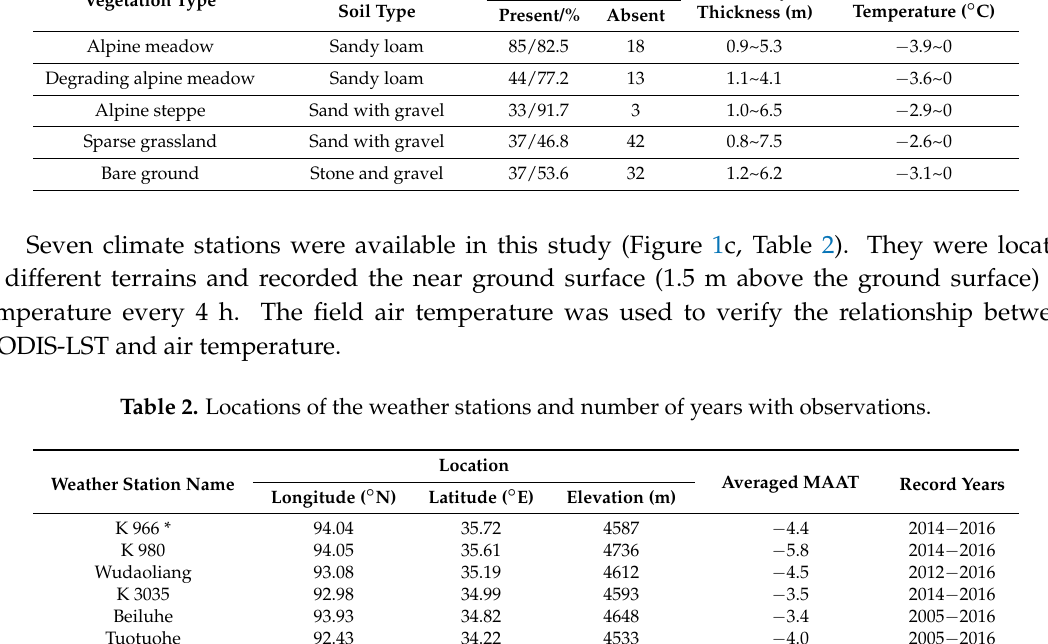
Table 1. Summary of field data collected in different vegetation, topographic, and geologic settings. Vegetation Type